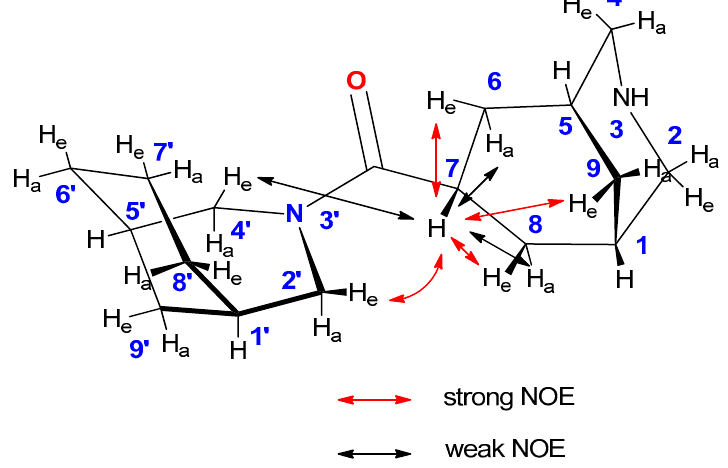
Figure 2. NOE correlations for 7-CH 1 H-NMR peak in the 2D-NOESY spectrum of compound 14 .